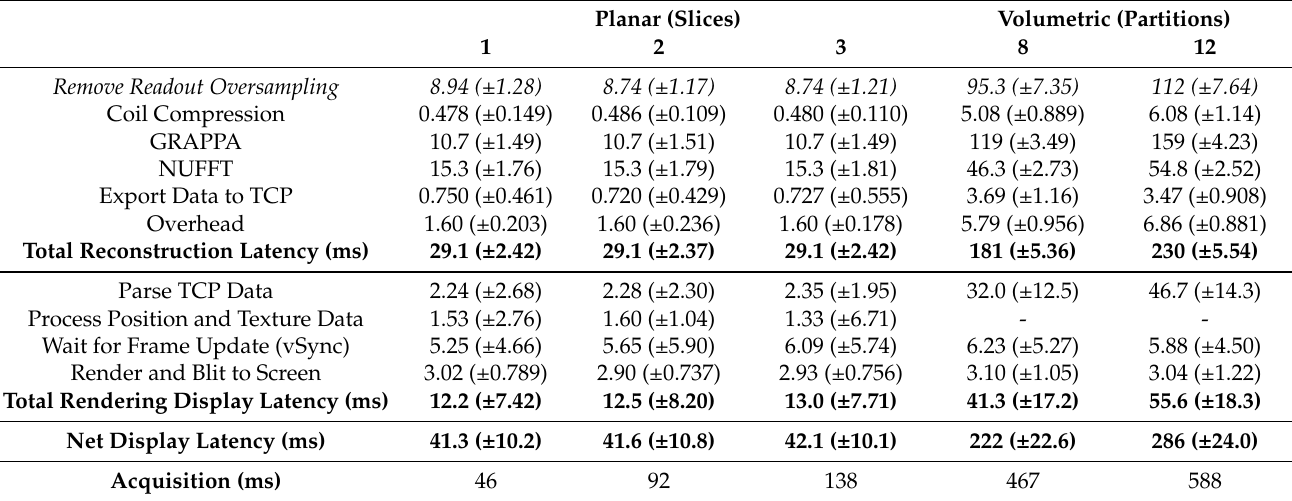
Table 1. Time required by the main components in the system to process one frame of data for different dataset sizes. The net display latency is the sum of the total reconstruction latency and the total rendering display latency. In order to achieve real-time imaging, the net display latency must be shorter than the acquisition time. The reconstruction latency is the sum of the listed main sub-steps and overhead steps. It captures the processing time between when all data have been buffered and when the image is exported for display. Note that the readout oversampling is removed from each line of data as it is acquired, so this step is not included in the latency. The total rendering display latency is the sum of the sub-steps listed. Process timings are calculated as an average per slice or volume because the net display latency depends on processing that occurs after the acquisition of the last slice or volume per